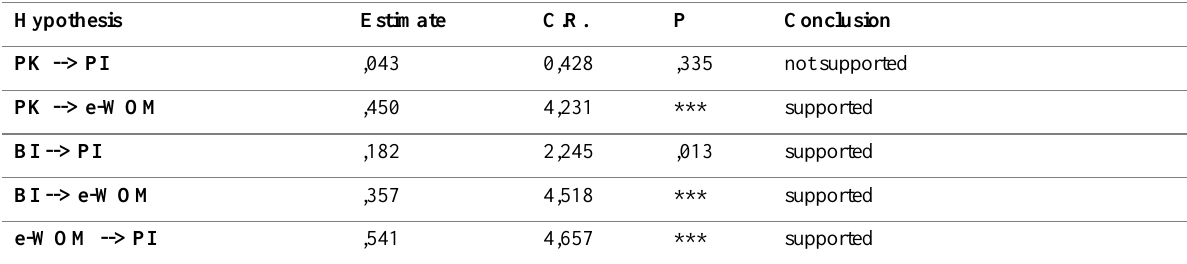
Table 2: Hypothesis Test